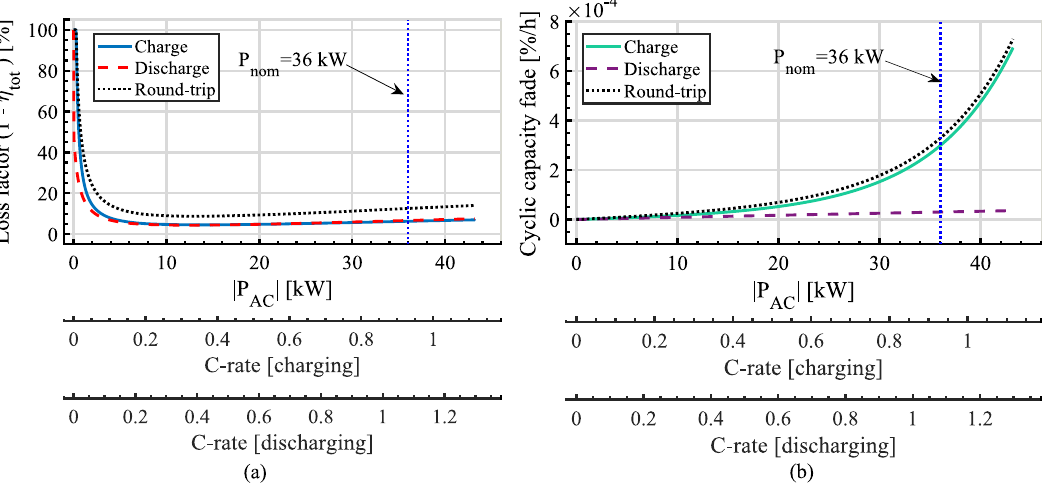
Figure 3. Loss factor ( a ) and battery ageing ( b ) analysis with dependence on alternating current (AC)-side system power. The nominal power rating of 36 kW for the inverter is indicated with a dotted line. The x-axis shows both the AC power and the C-rate in charge/discharge directions, separately.